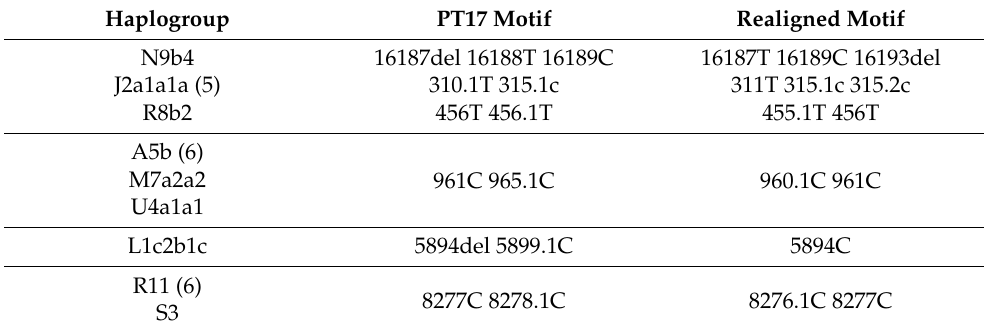
Table 5. Realigned motifs.